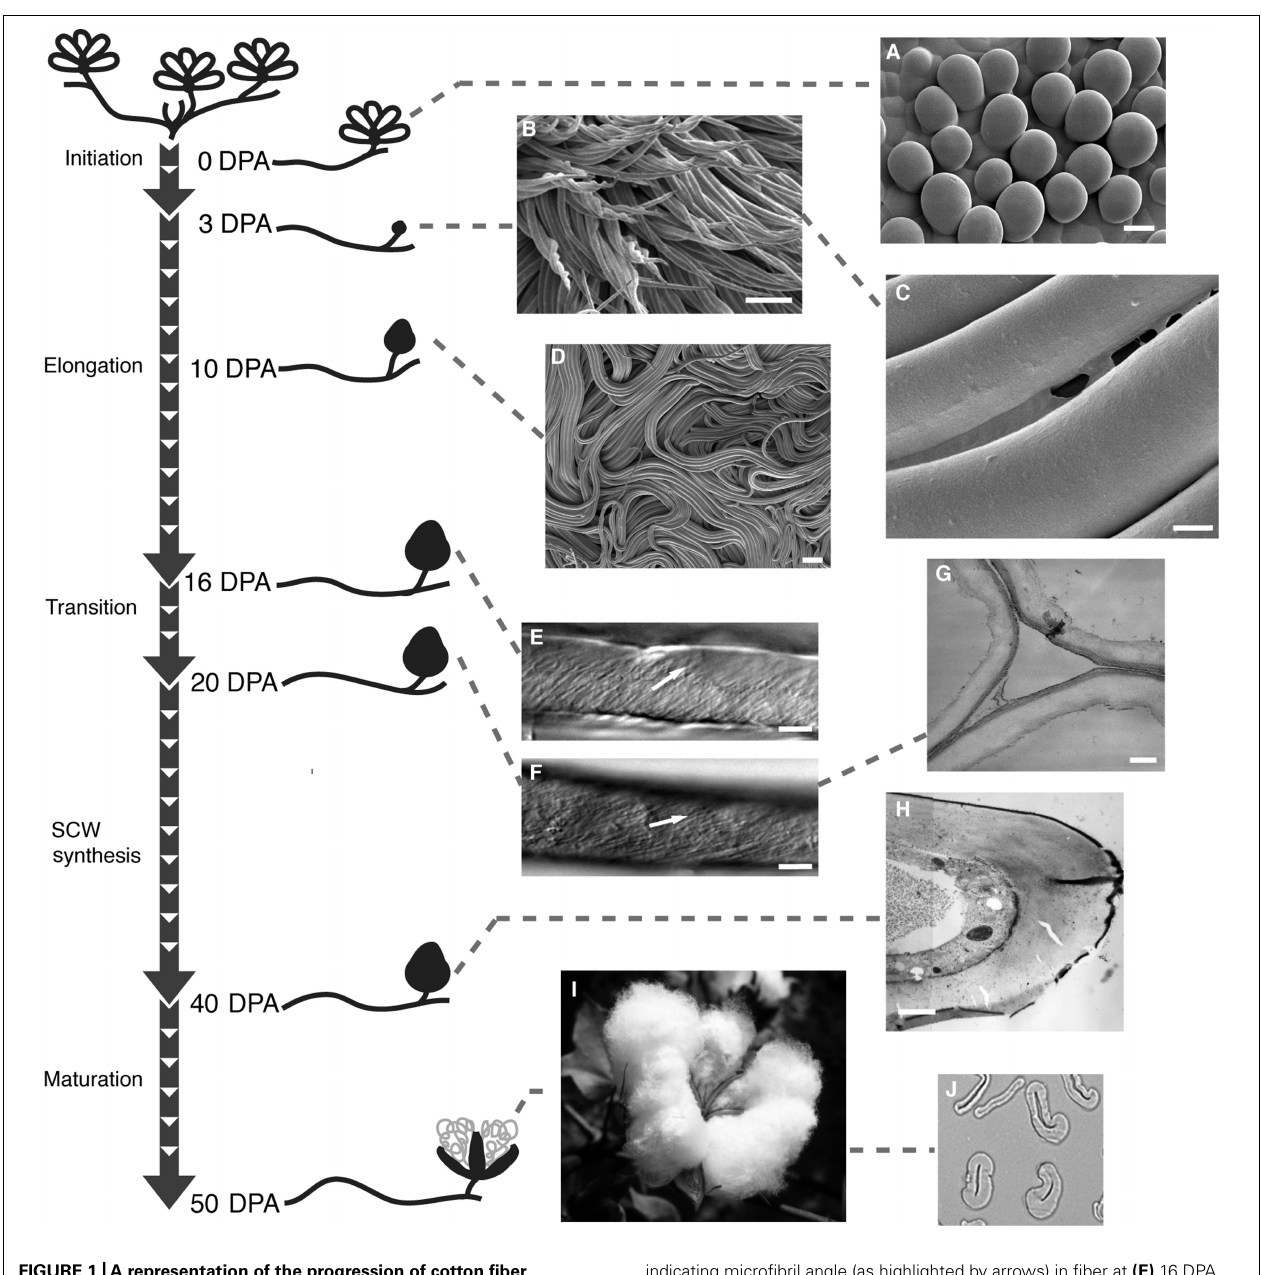
indicating microfibril angle (as highlighted by arrows) in fiber at (E) 16 DPA and (F) 20 DPA (bars = 10 μ m).TEM fiber cross-section show (G) an early stage of secondary wall thickening (bar = 300 nm); and (H) a more advanced stage of secondary wall deposition (bar = 1 μ m). (I) Mature cotton boll and (J) cross-section of mature fiber viewed in the light microscope. SCW, secondary cell wall. Re-published with permission fromThe